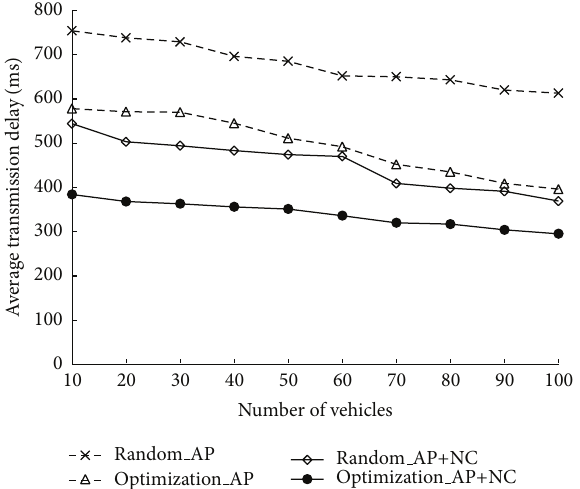
Figure 2: Comparison figure of the average transmission delay.